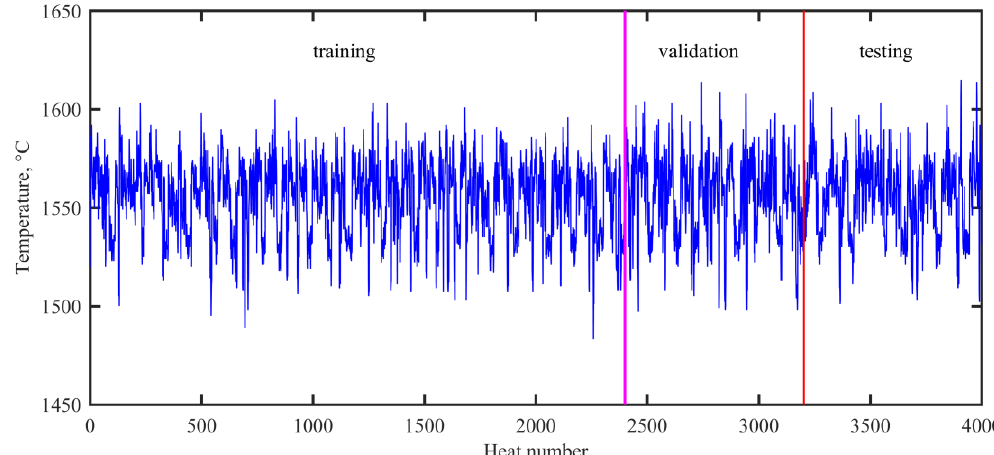
Figure 2. Evolution of the end temperature in the VTD.